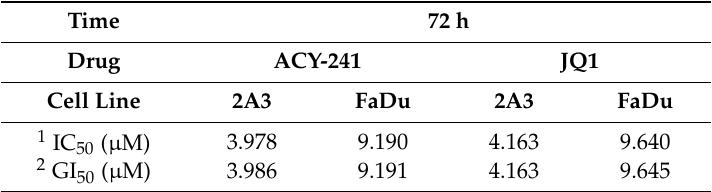
Table 1. IC 50 and GI 50 values of ACY-241 and JQ1 in 2A3 and FaDu cells.